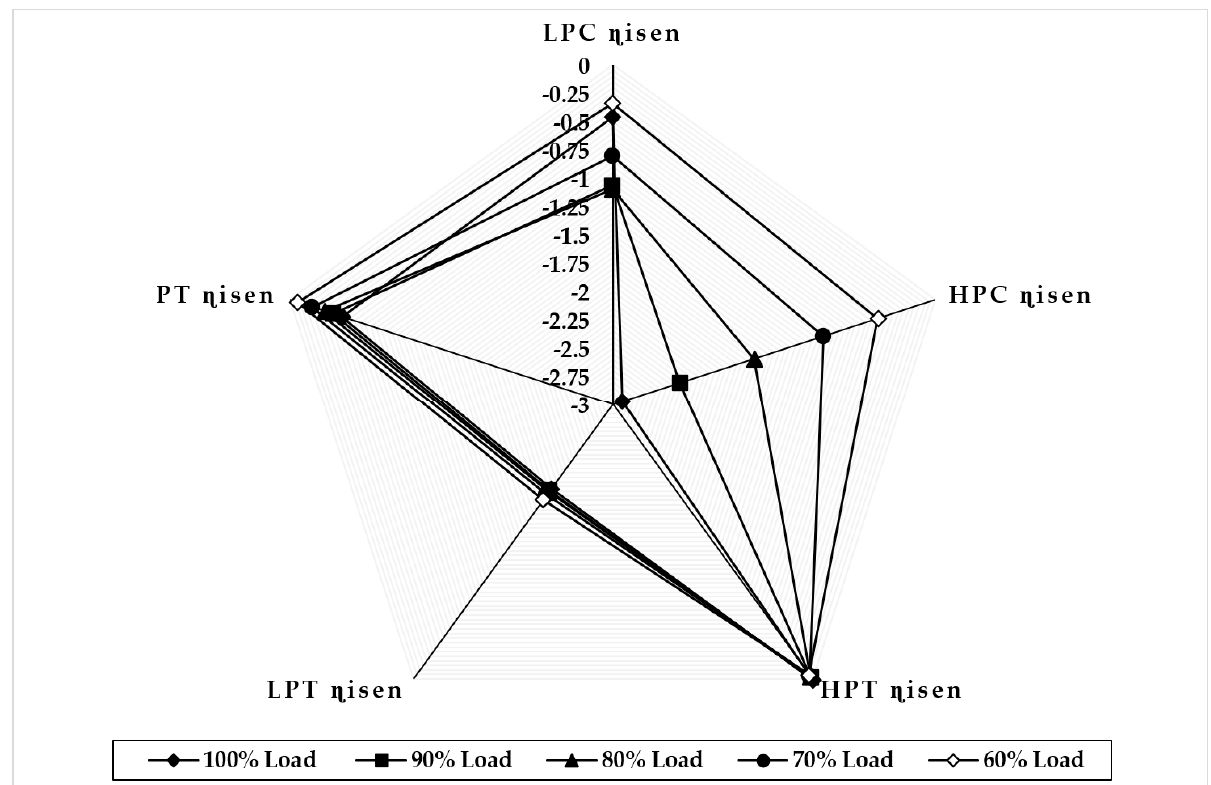
Figure 14. Deviation in component isentropic efficiency due to LPT erosion at 100% fault severity at full − load and part − load operation.